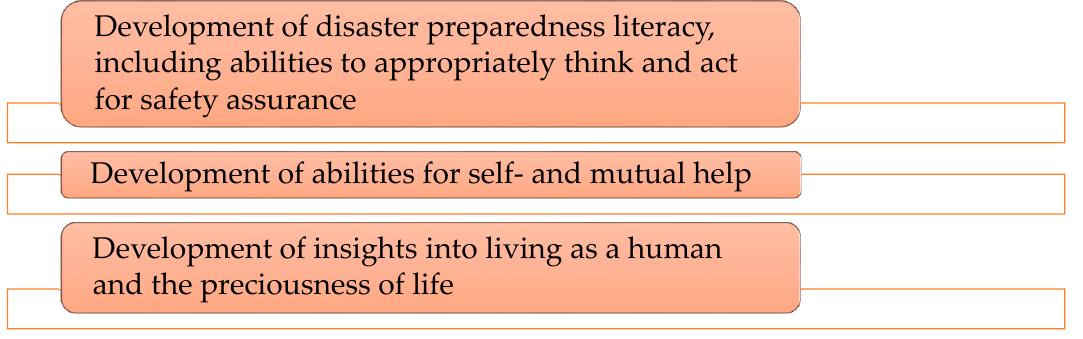
Figure 2. Purposes of education specified in disaster preparedness plans for schools.